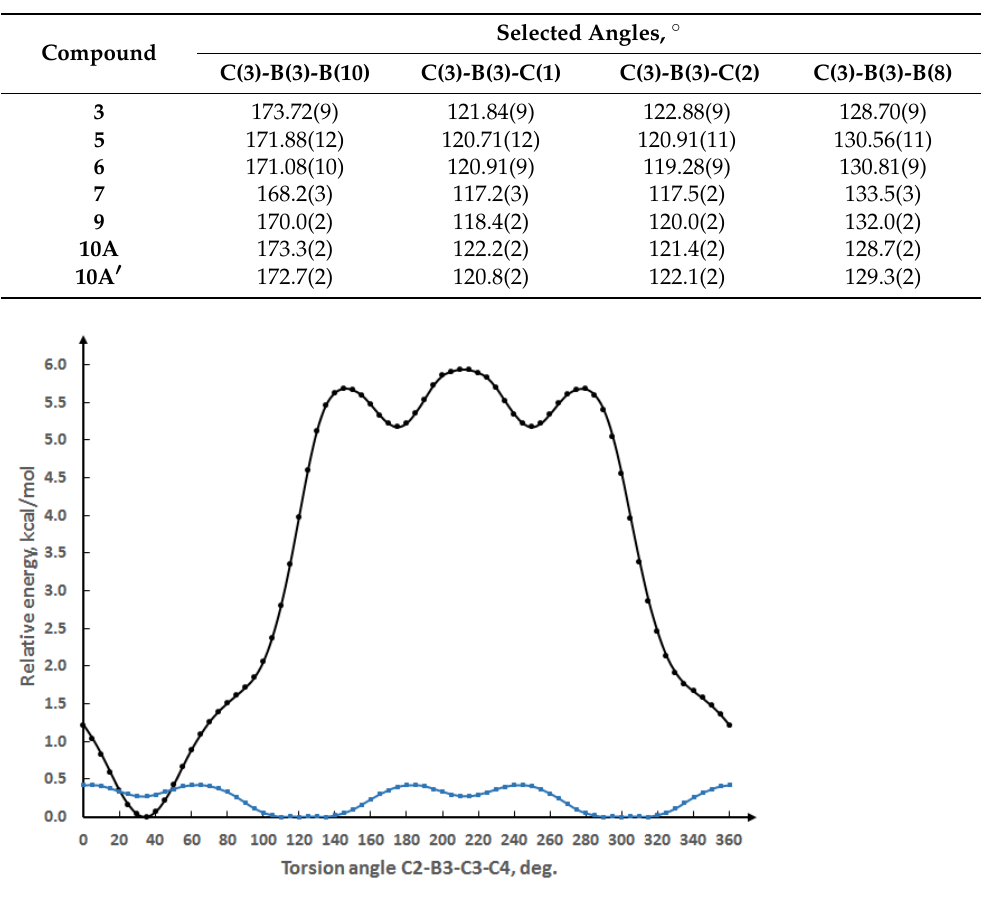
Figure 2. Dependence of conformational energy on C(2)-B(3)-C(3)-C(4) torsion angle for compounds 6 (black curve) and 7 (blue curve).